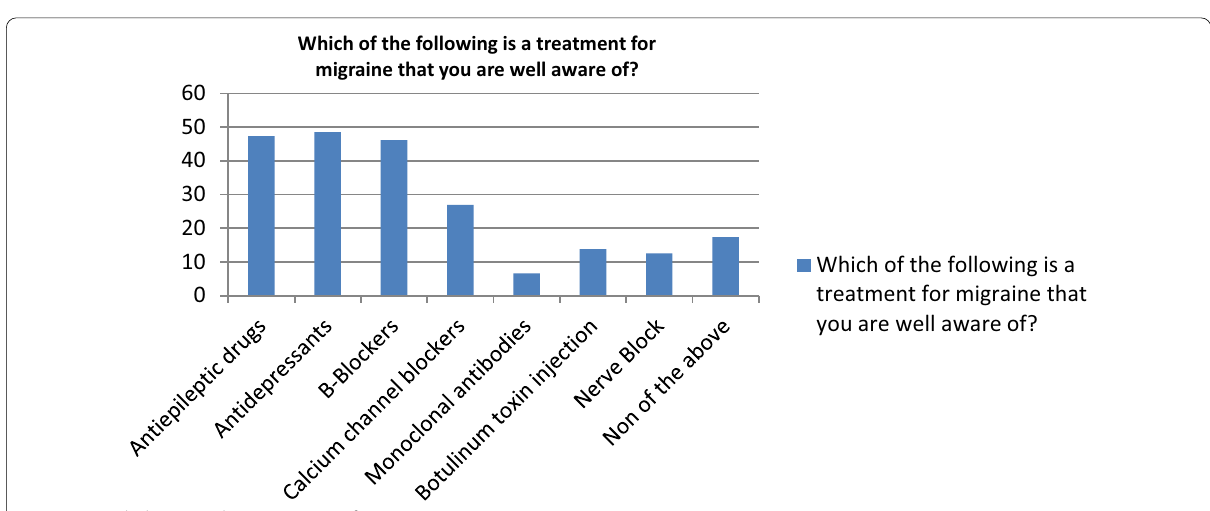
Fig. 5 Knowledge regarding treatment of